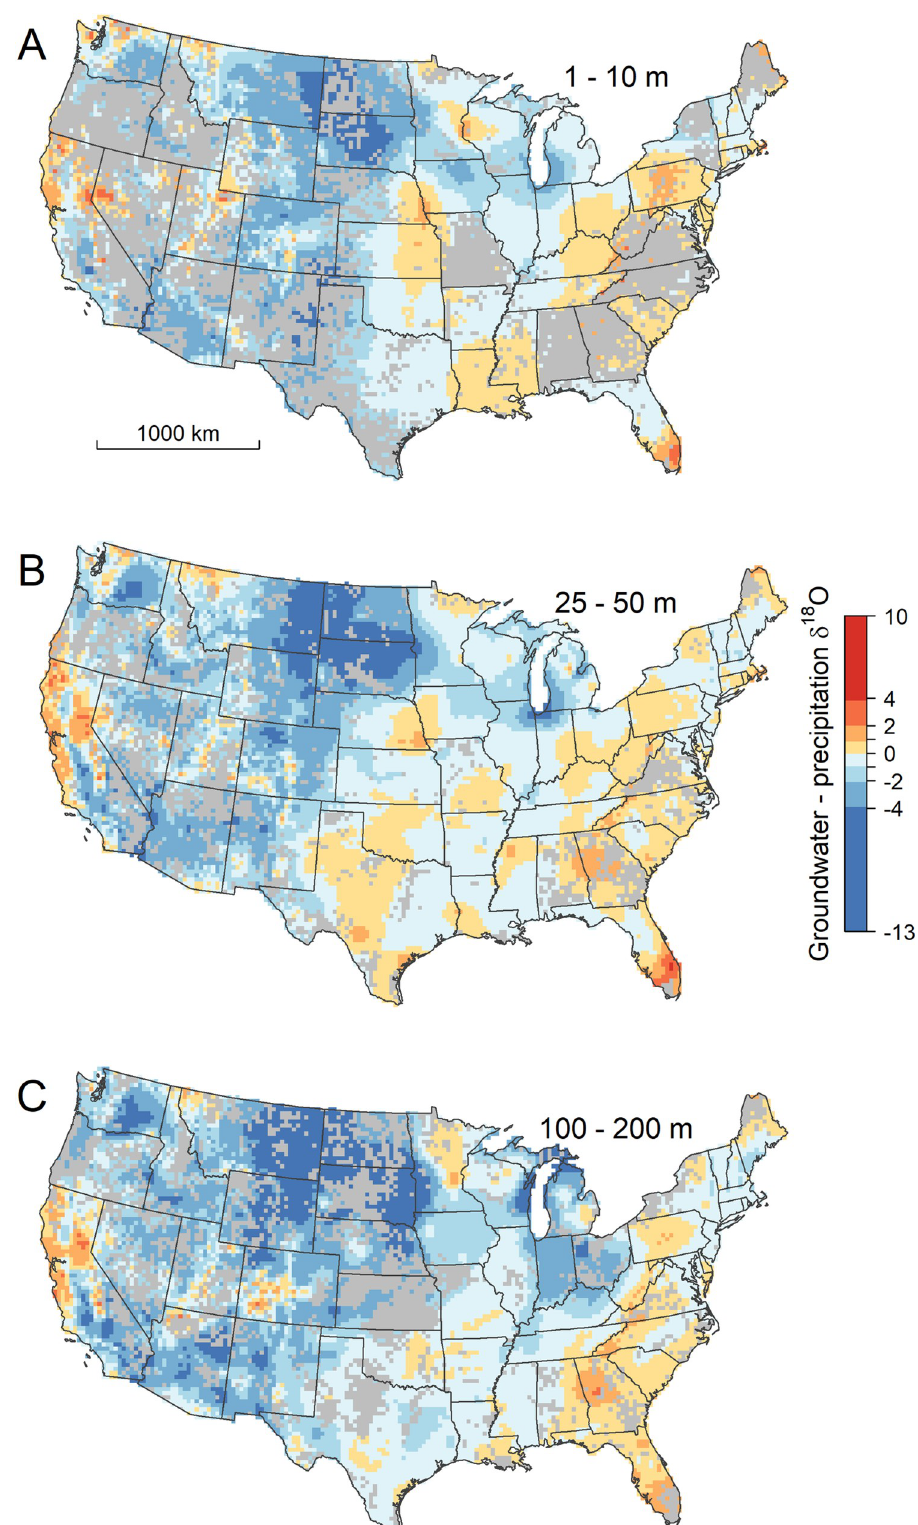
Fig 5. The difference in δ 18 O values between interpolated groundwater and modern, annual-average precipitation at shallow (A), intermediate (B), and deep (C) depths. Gray cells contain no wells completed within the mapped depth